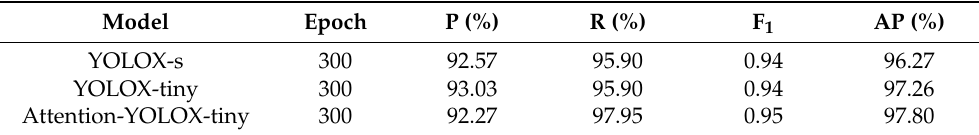
Table 3. Detection evaluation of different networks.